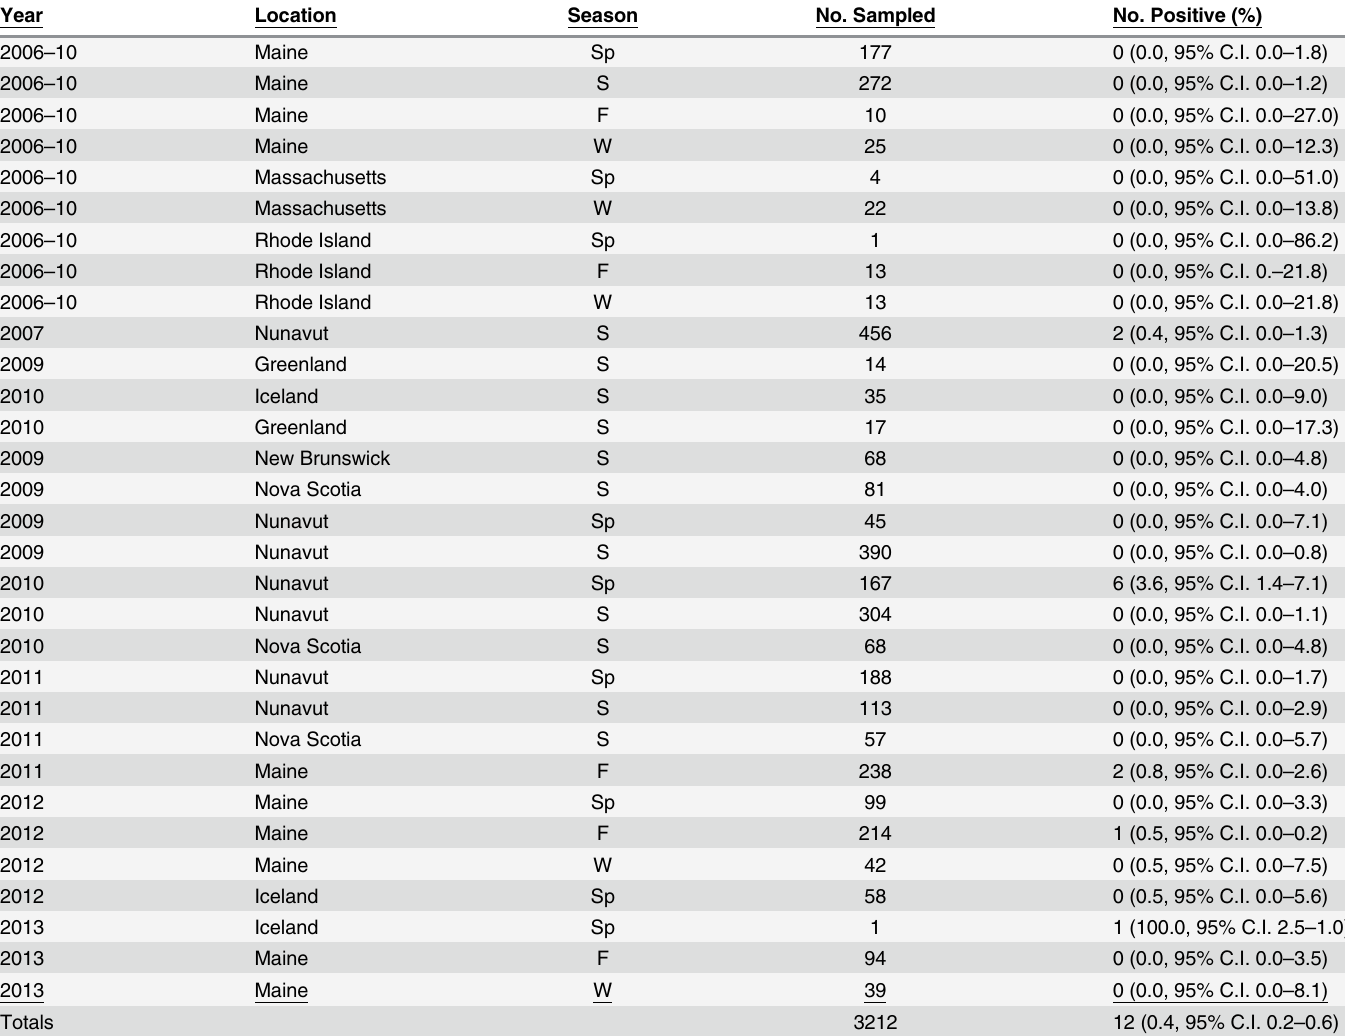
Table 4. RT-PCR detection of avian influenza virus RNA in North Atlantic common